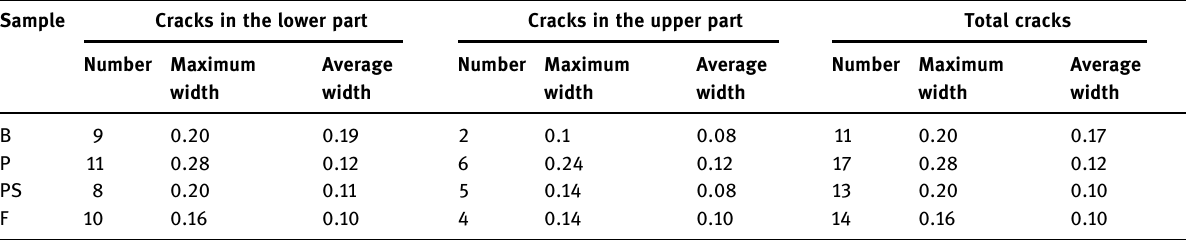
Table 7: Summary of cracks in concrete beams